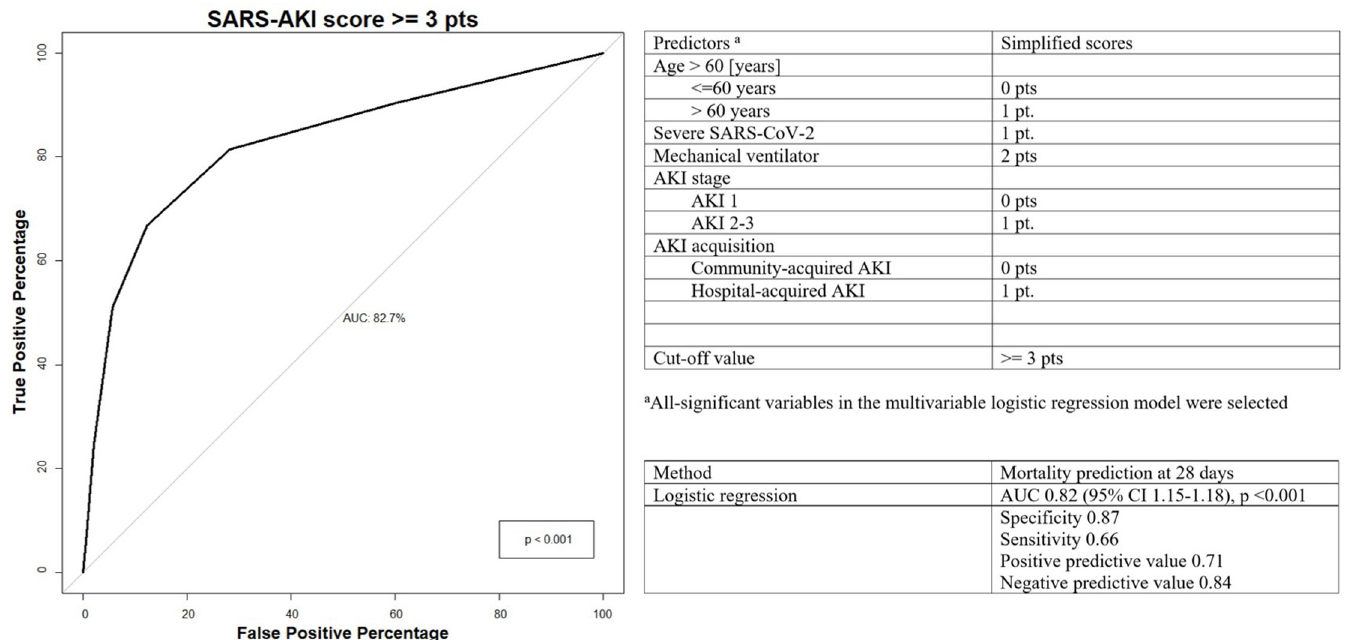
Fig 4. COVID-AKI score as a tool for predicting death in COVID AKI patients and the ROC curve of the logistic regression model for predicting all-cause mortality.